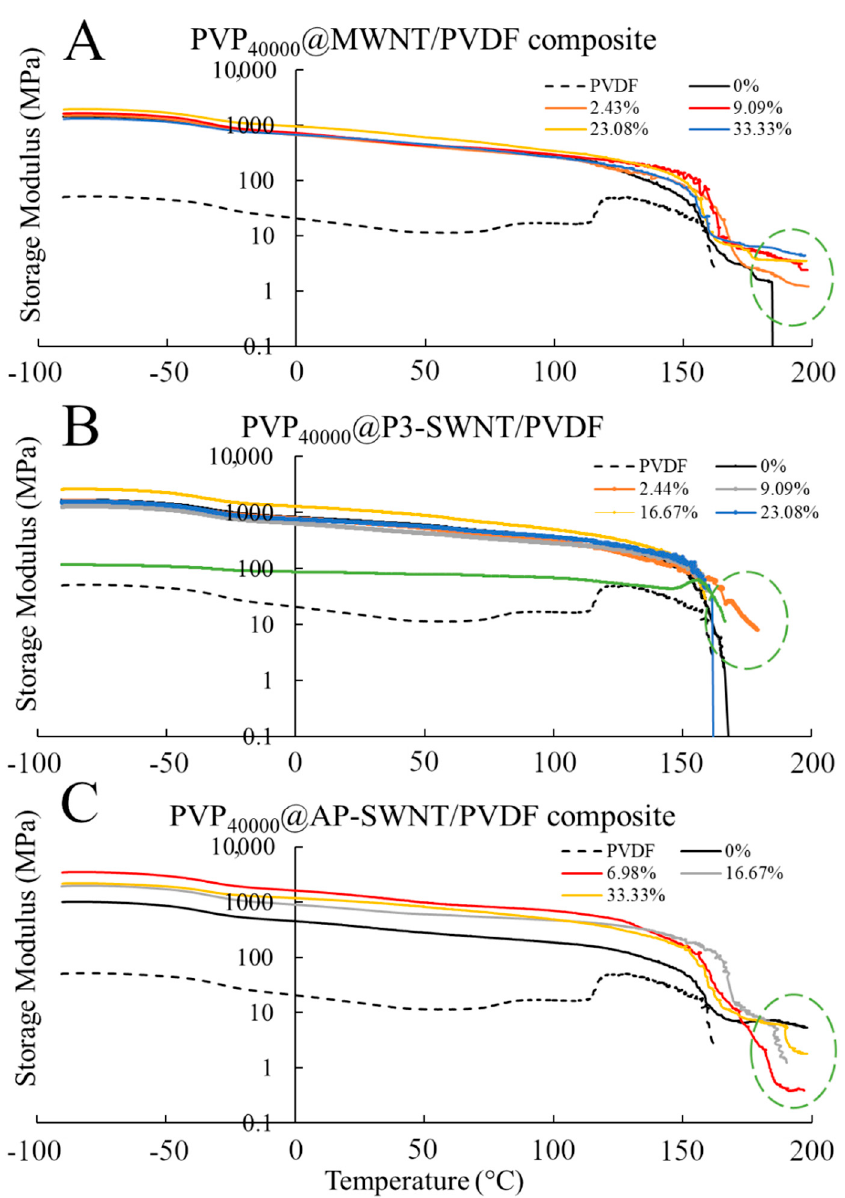
Figure 4. Storage Modulus of PVP 40000 functionalized MWNT ( A ); P3-SWNT ( B ); and AP-SWNT ( C ) in PVDF composite.